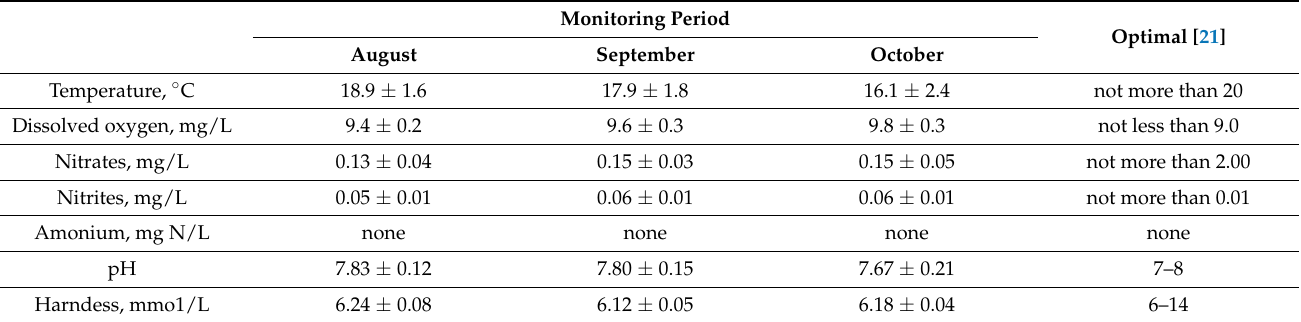
Table 1. Water quality self-monitoring (mean ±